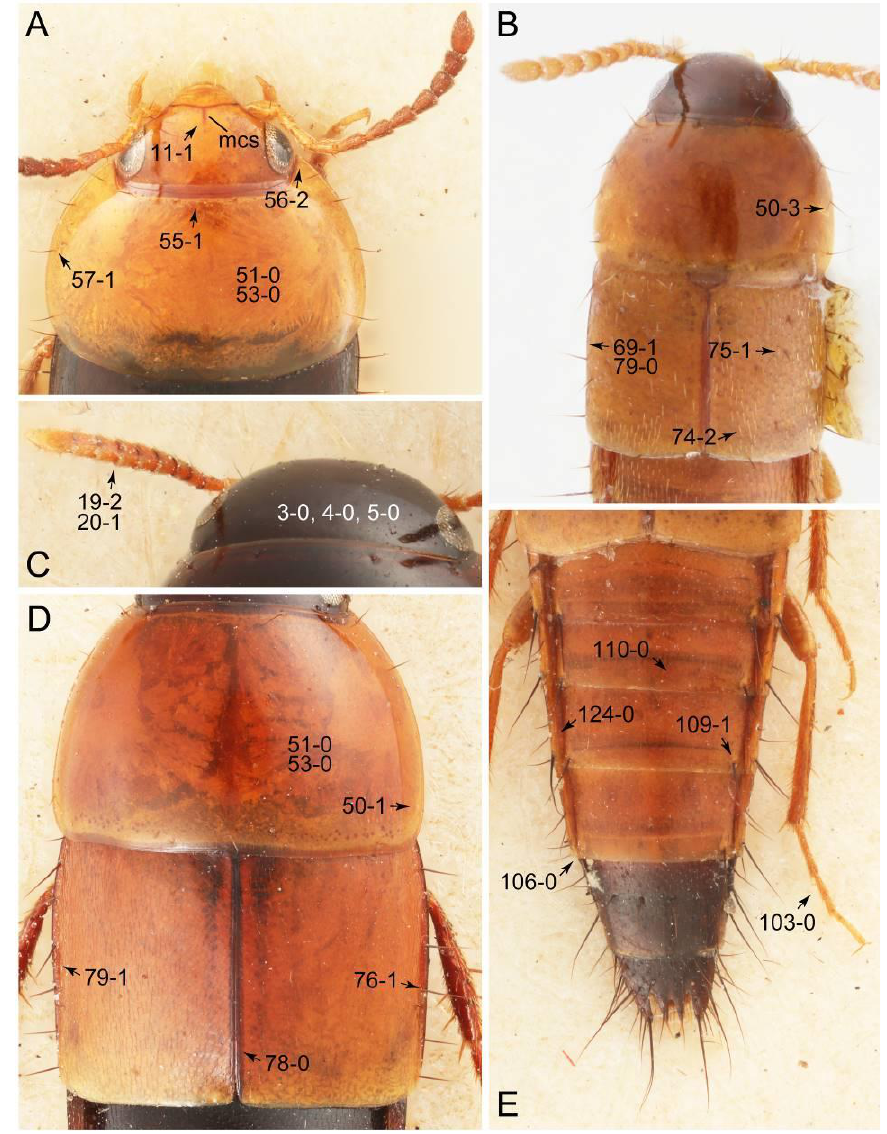
Figure 7. Photographs of body parts of Tachyporini: Tachyporina, enlarged. ( A ) head and pronotum of Tachyporus obtusus (Linnaeus), dorsal view. ( B ) forebody of Palporus nitidulus , dorsal view. ( C ) head and antenna of Lamprinus erythropterus , dorsal view. ( D ) pronotum and elytra of Lamprinodes saginatus , dorsal view. ( E ) female abdomen of Tachyporus obtusus , dorsal view. Abbreviation: mcs, midcranial suture. Characters and character states (format X-X) are indicated on each